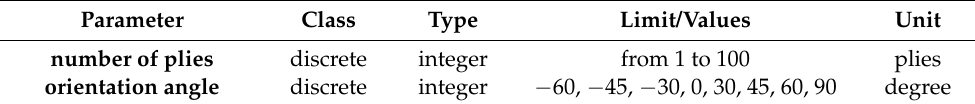
Table 3. Geometrical parameters related to laminate stacking sequence to be